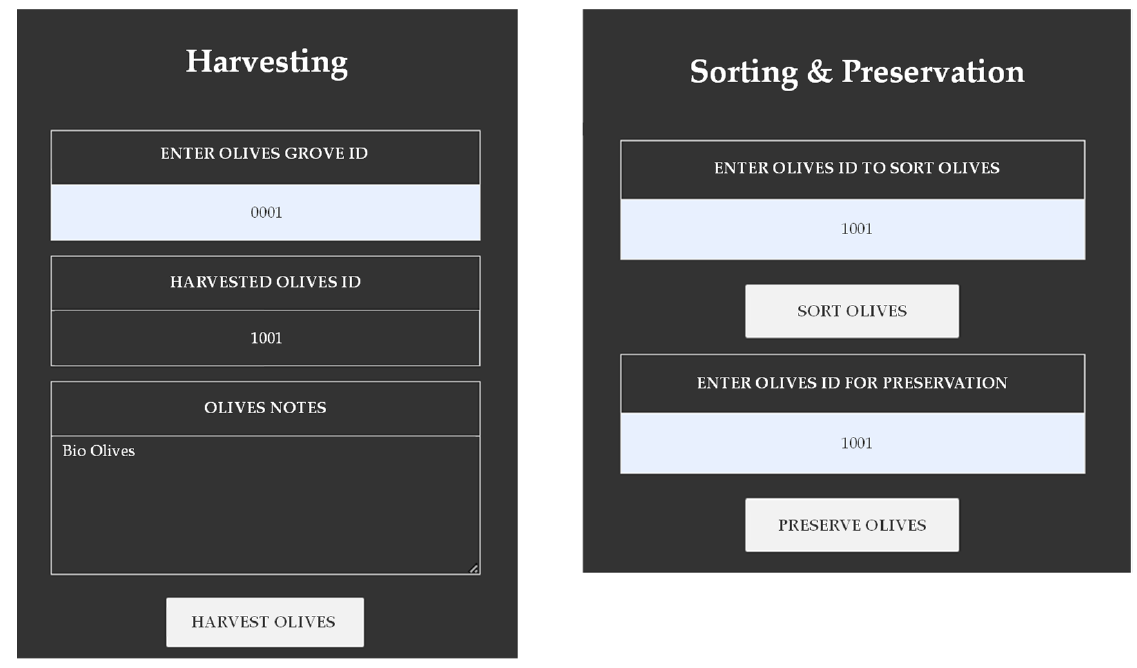
Figure 4. Harvesting, Sorting, and Preservation of Olives.